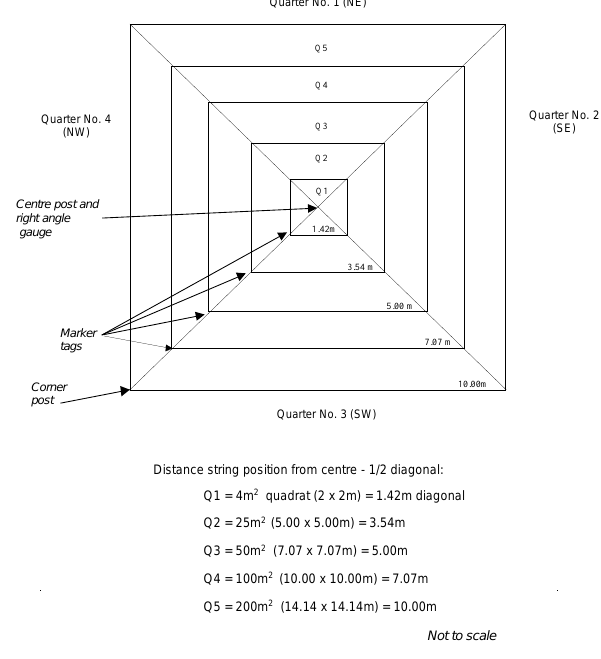
Figure 2. Layout of vegetation plot.